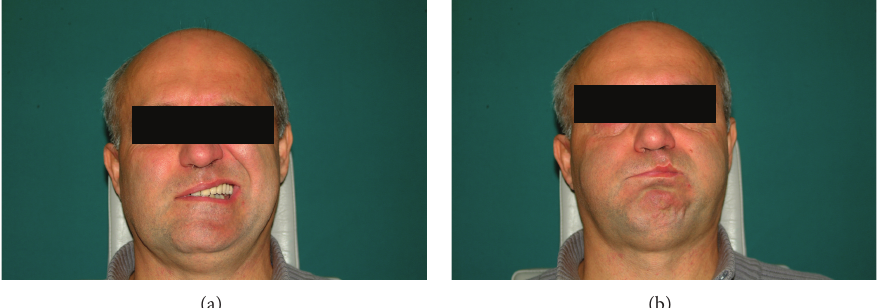
Figure 3: Thirteen days following stapedotomy, House-Brackmann grade III facial palsy is observed on the right side: teeth showing (a) and lip rounding (b).